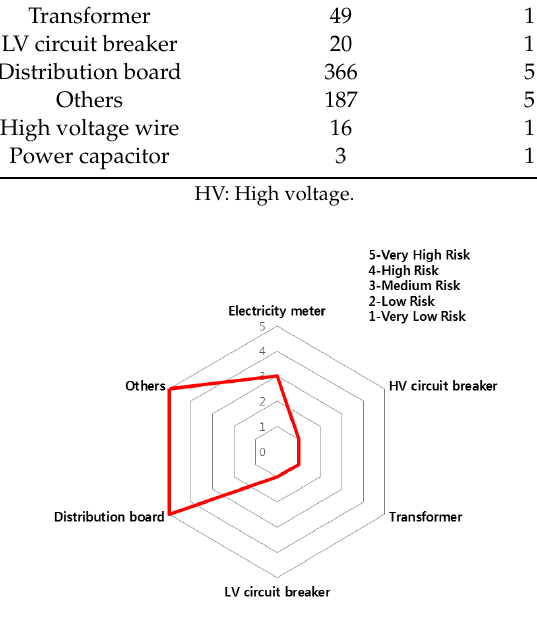
Figure 20. The risk rating for ignition equipment by device.